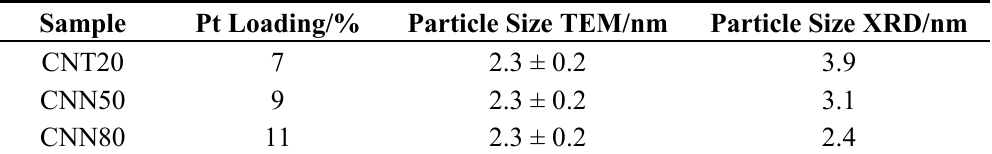
Table 2. Electrocatalyst physical chemical